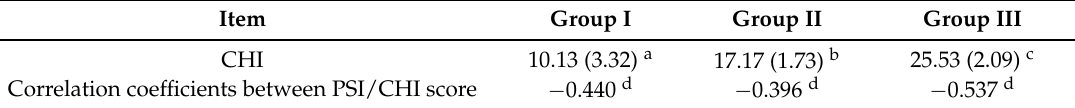
Table 3. Distribution of the Chinese Happiness inventory (CHI) scores in the three groups. Item Group I Group II Group III CHI 10.13 (3.32) a ´ 0.440